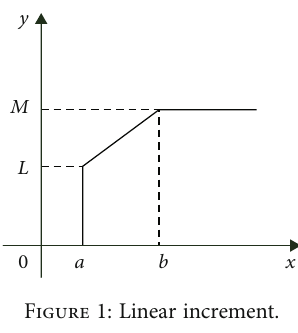
Figure 1: Linear